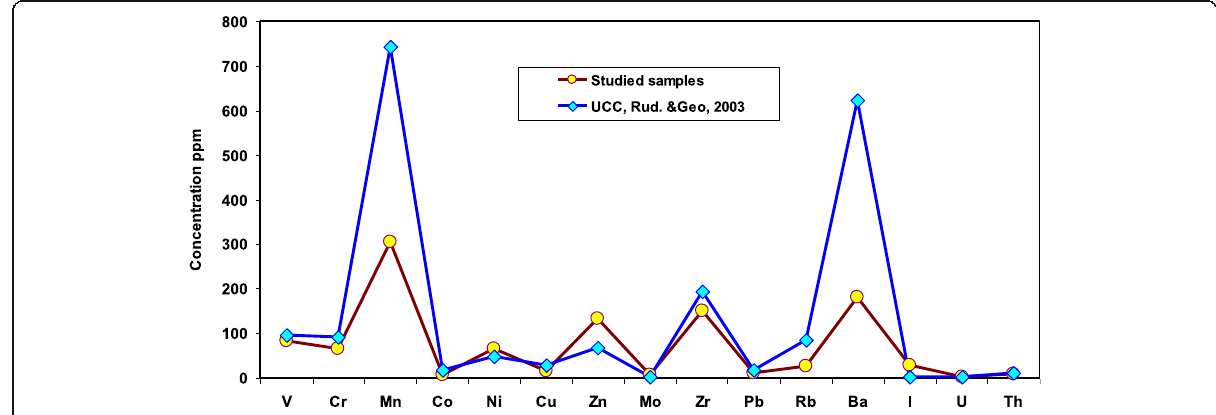
Fig. 3 The concentration of the trace elements of the studied carbonate rocks compared with the UCC (Rudnick and Gao 2003)